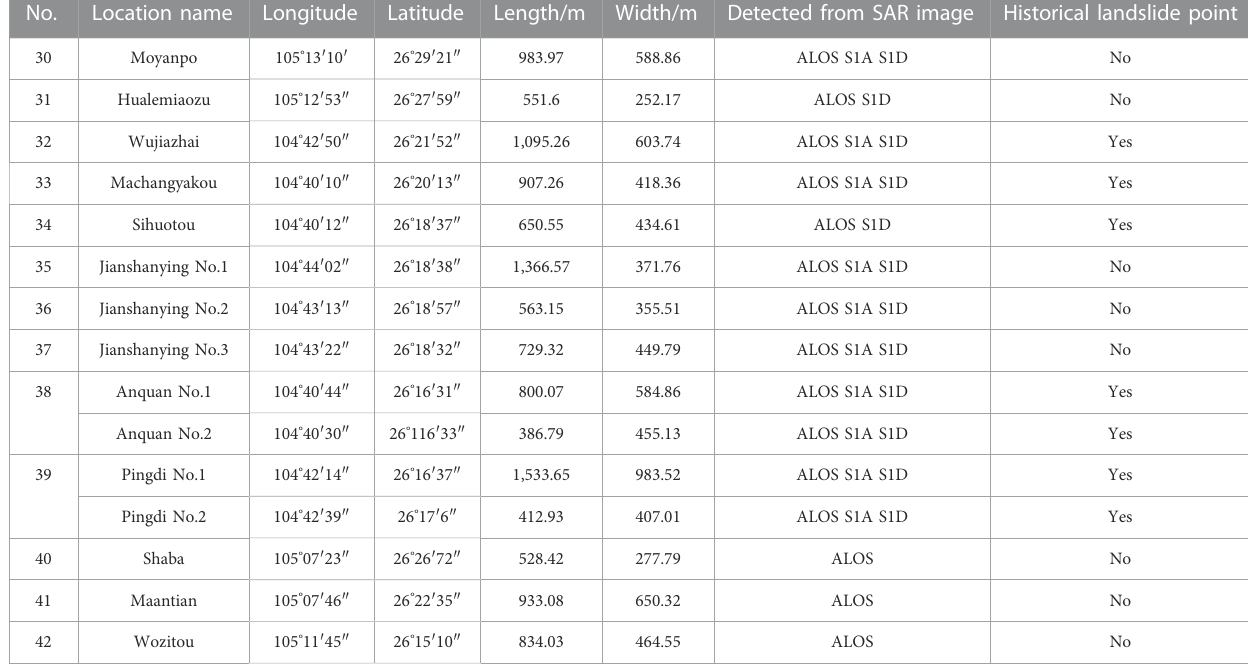
Frontiers in Earth